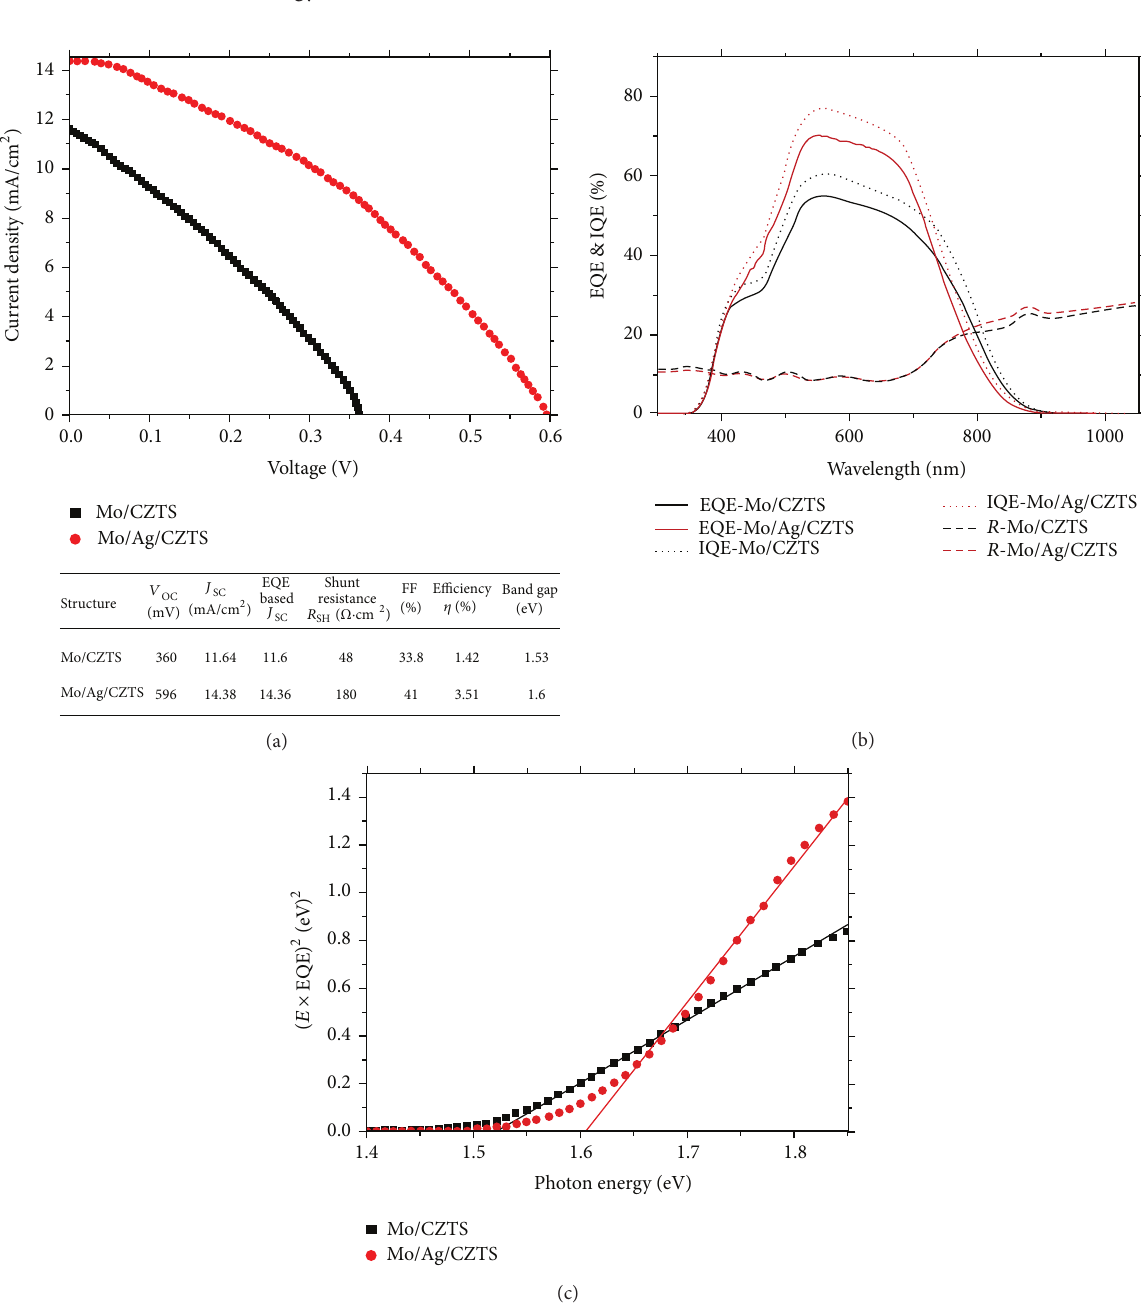
Figure 6: (a) Light 𝐽 - 𝑉 curve of the CZTS devices with and without the Ag intermediate layer measured at 25 ∘ C under AM 1.5 G illumination. , 𝐽 , FF, and shunt resistance 𝑅 are given in the inset table; (b) external quantum efficiency (EQE), internal quantum The efficiency, 𝑉 OC SC SH efficiency (IQE), and reflectance ( 𝑅 ) of the CZTS solar cells with and without the Ag layer; and (c) band gap estimation plot ( 𝐸 × EQE) 2 versus 𝐸 , where 𝐸 is the photon energy. Band gap results are also listed in the inset table in